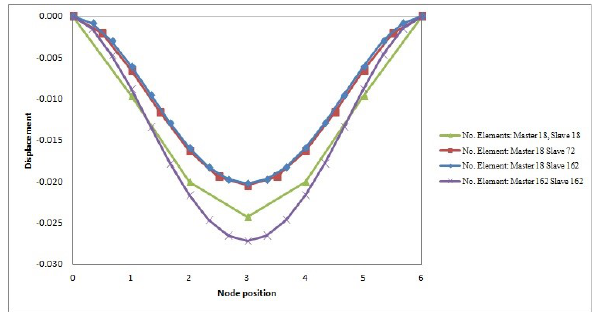
Figure 12: Transverse displacement u 3 distribution for a double- layer shell with Adini-Clough elements and highly mismatched non-conforming mesh